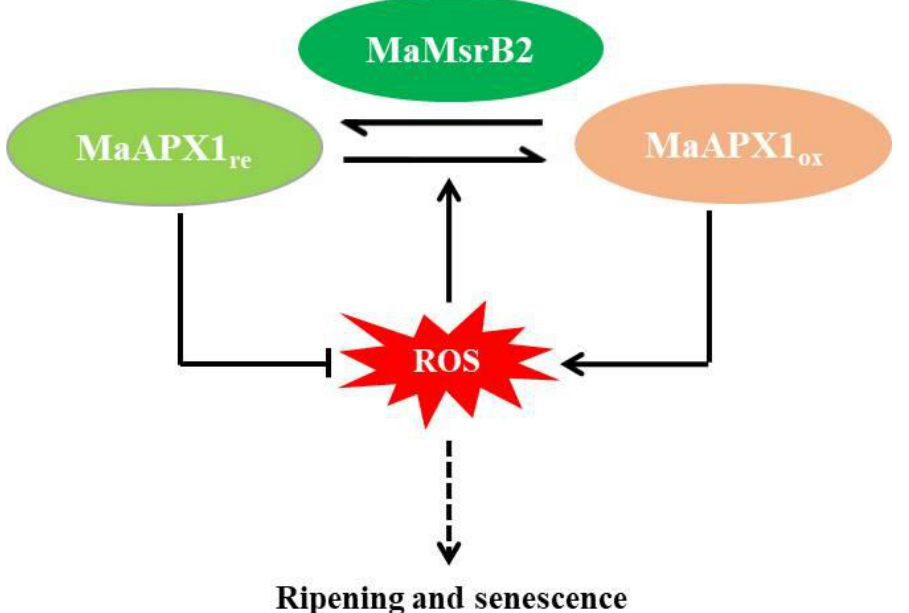
Figure 7. A proposed model of the involvement of MaMsrB2-mediated redox modification of 7 methionine in MaAPX1 in regulating ripening and